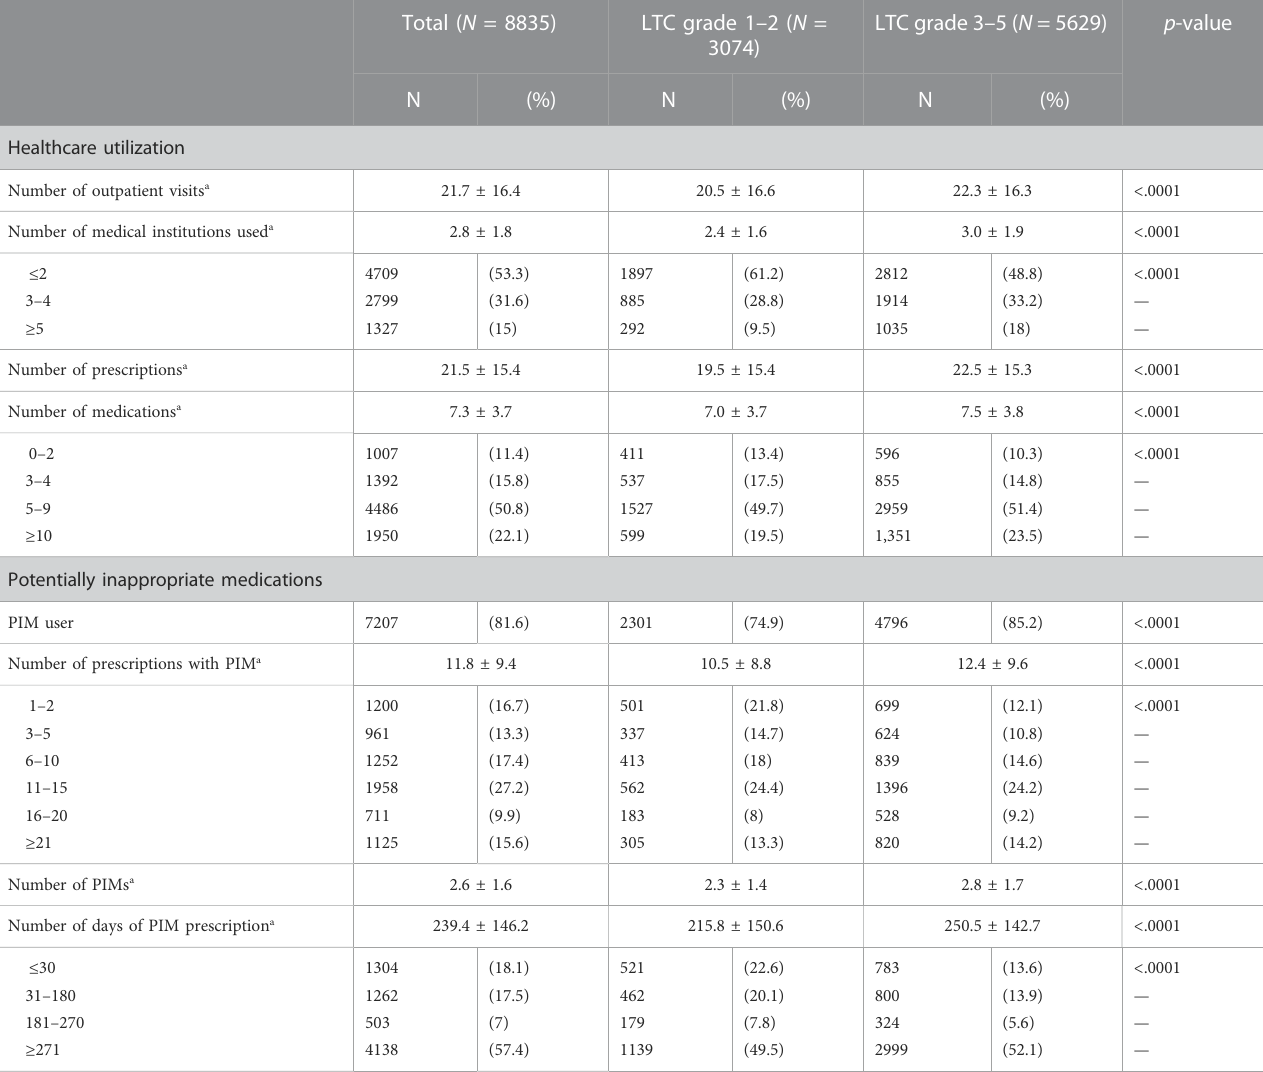
TABLE 2 Healthcare utilization and potentially inappropriate medication use according to the LTC